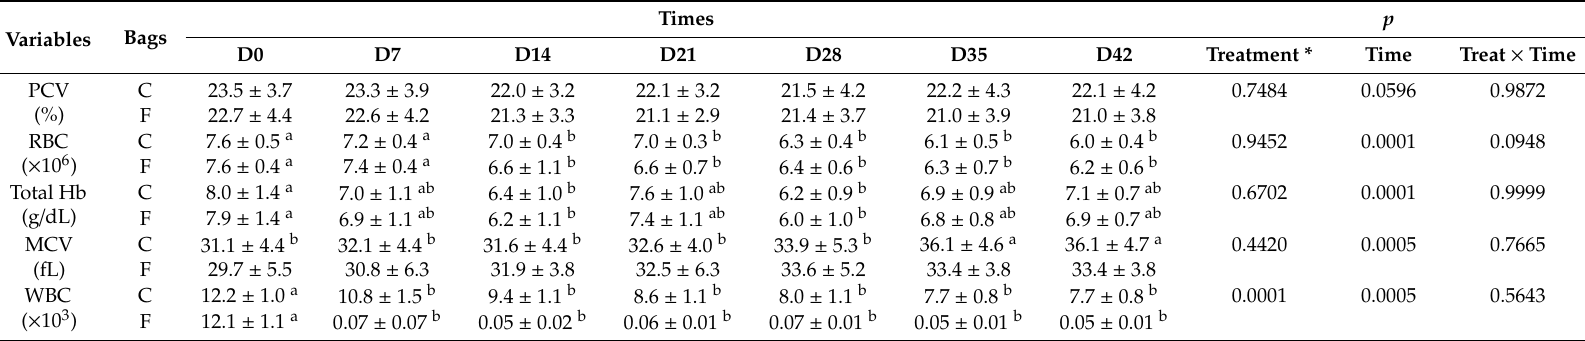
Table 1. Mean values and standard deviations of the hematological variables of the cattle whole blood stored in CPD / SAG-M (Control (C)) and CPD / SAG-M with Filter (Filter (F)) bags for 42 days.